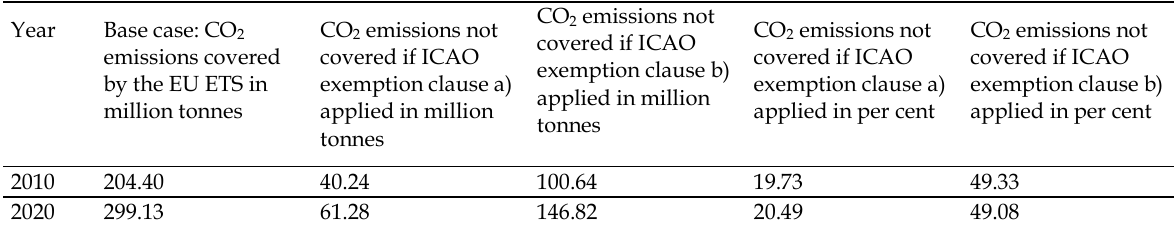
Table 9. CO 2 emissions not covered by the EU ETS if the ICAO exemption clause is